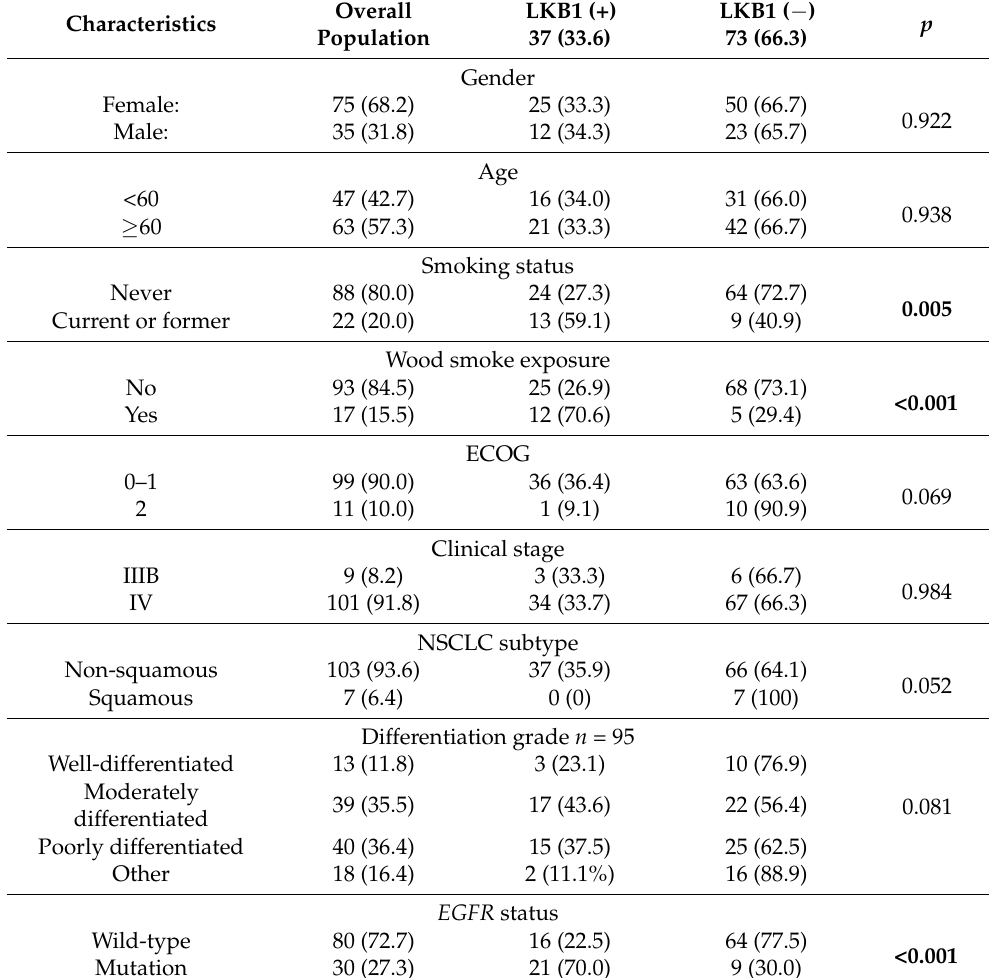
Table 1. Baseline characteristics of the entire population and according to LKB1 expression.